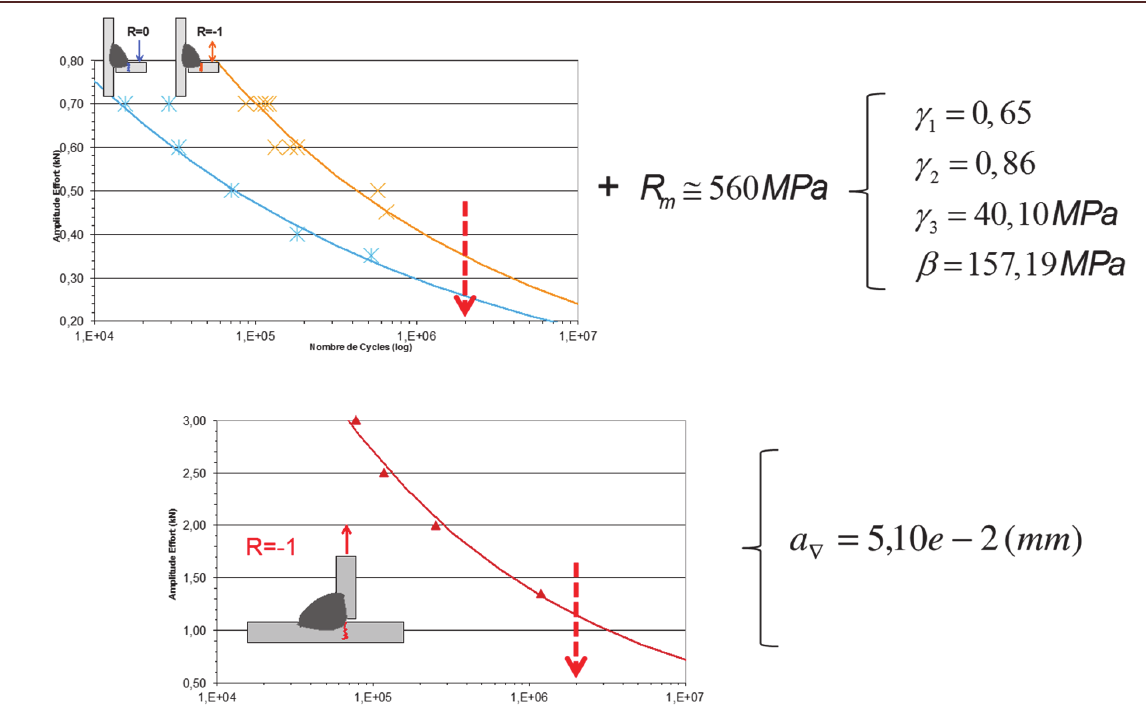
Figure 9: Identification procedure: fatigue criterion and gradient effect.